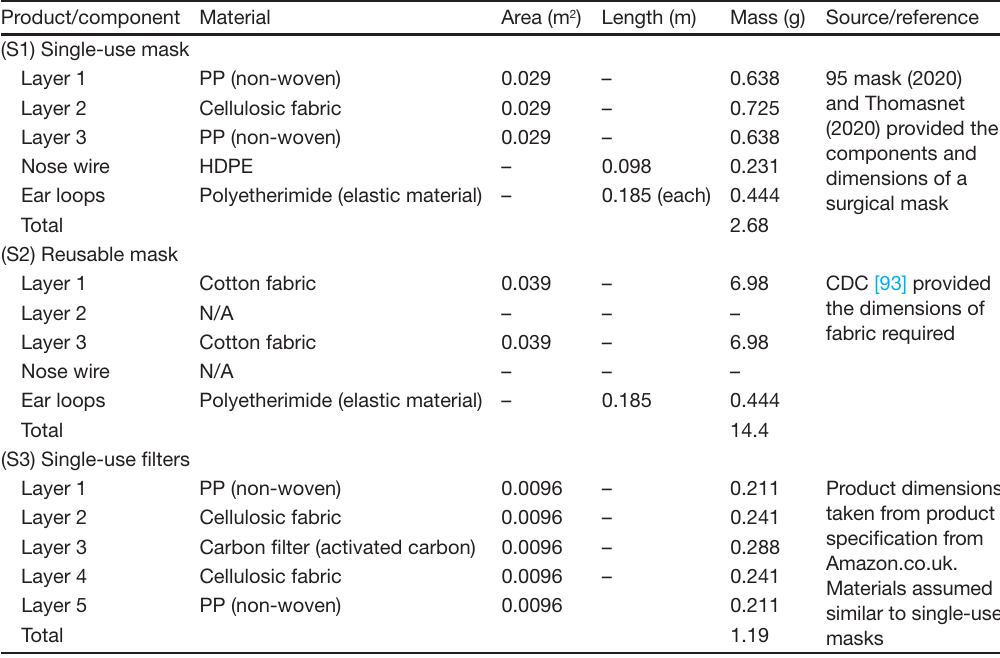
Table A4. Material of construction and mass used to model each product.